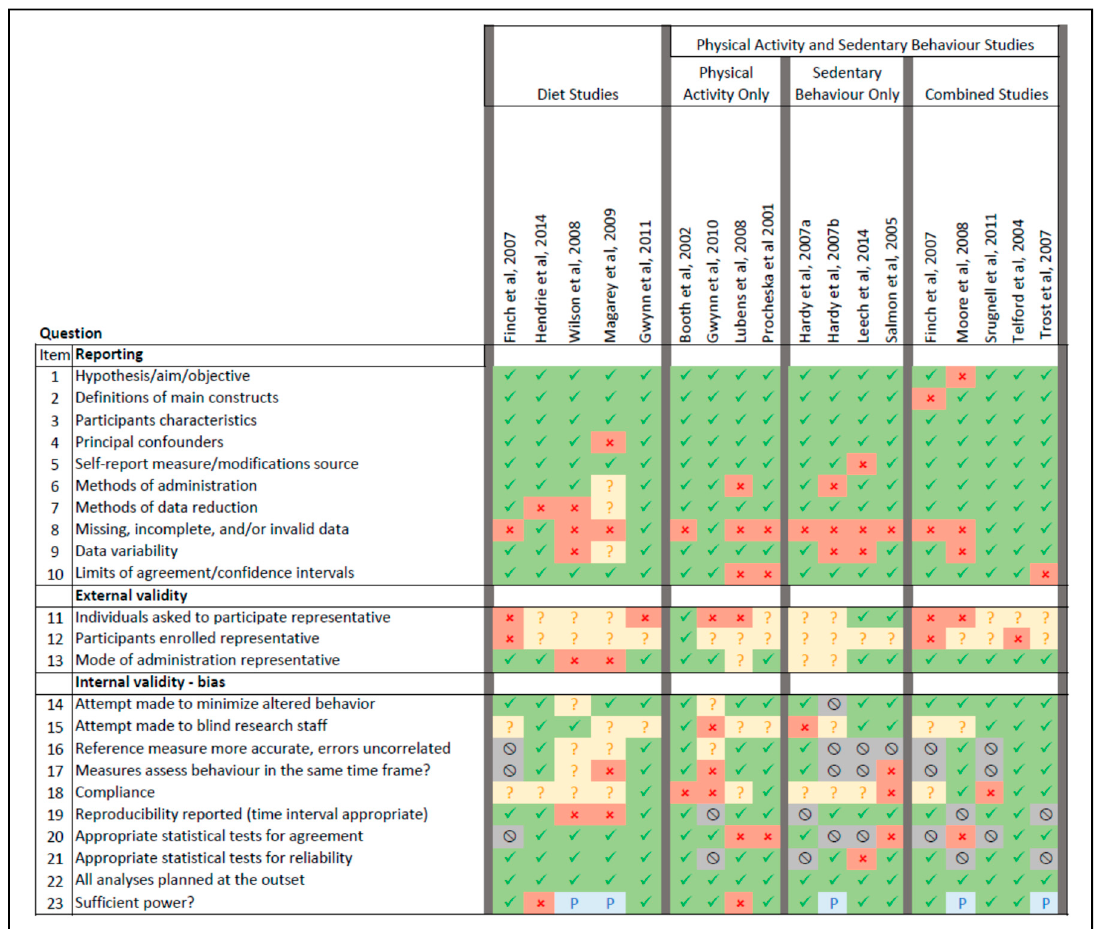
Figure 1. Visual summary of quality ratings for included individual studies. Green = yes, red = No, amber = unsure/unable to determine, grey = not applicable, blue = partially. The description of each question has been abbreviated.